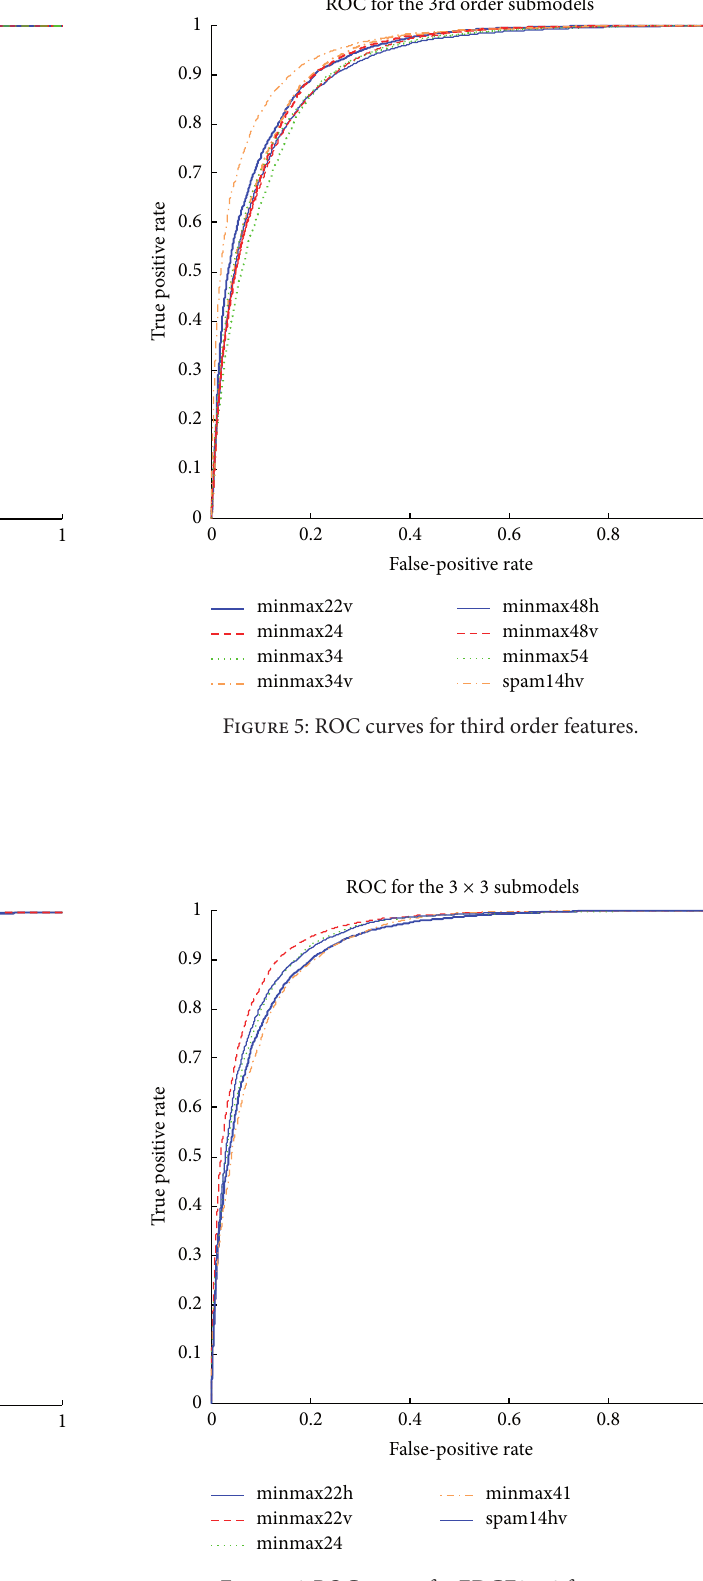
Figure 4: ROC curves for second order features.